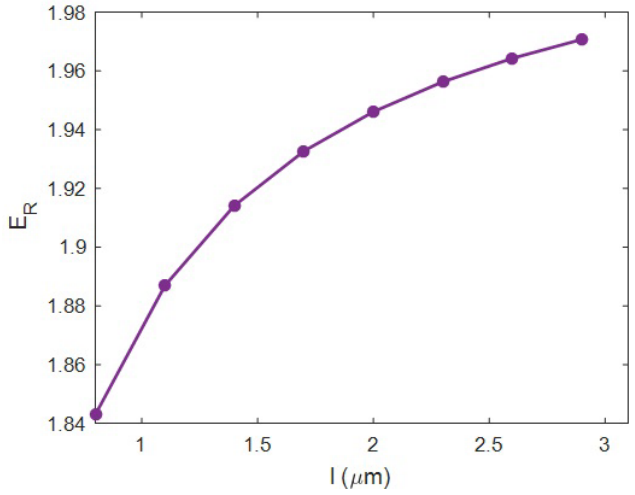
Figure 5. Dependency of relative modulus on the HNT length.